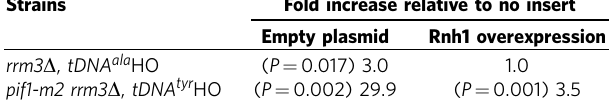
Table 3 | Fold increase of GCR rate ( rrm3 D ) or DR recombination frequency ( pif1-m2 rrm3 D ) relative to no tDNA insert with or without Rnh1 overexpression. Strains Fold increase relative to no